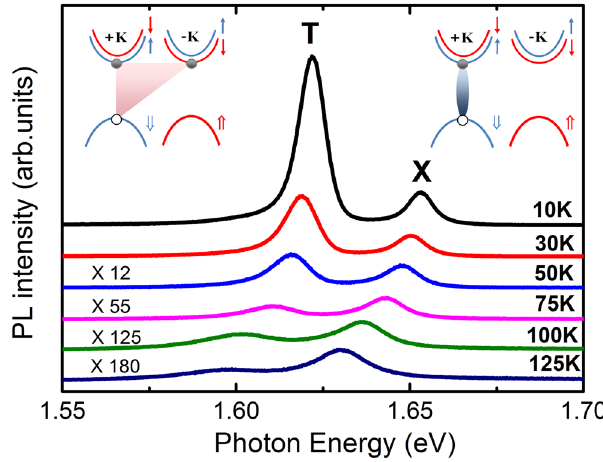
Figure 1. Temperature dependent photoluminescence spectra of monolayer MoSe 2 measured in the range of 10–125 K. Exciton (X) and trion (T) peaks are labeled. Band diagram of trion (left panel) and exciton (right panel) are sketched in the inset ( ⇑ and ↑ represents the hole and electron spin state in valence and conduction band,